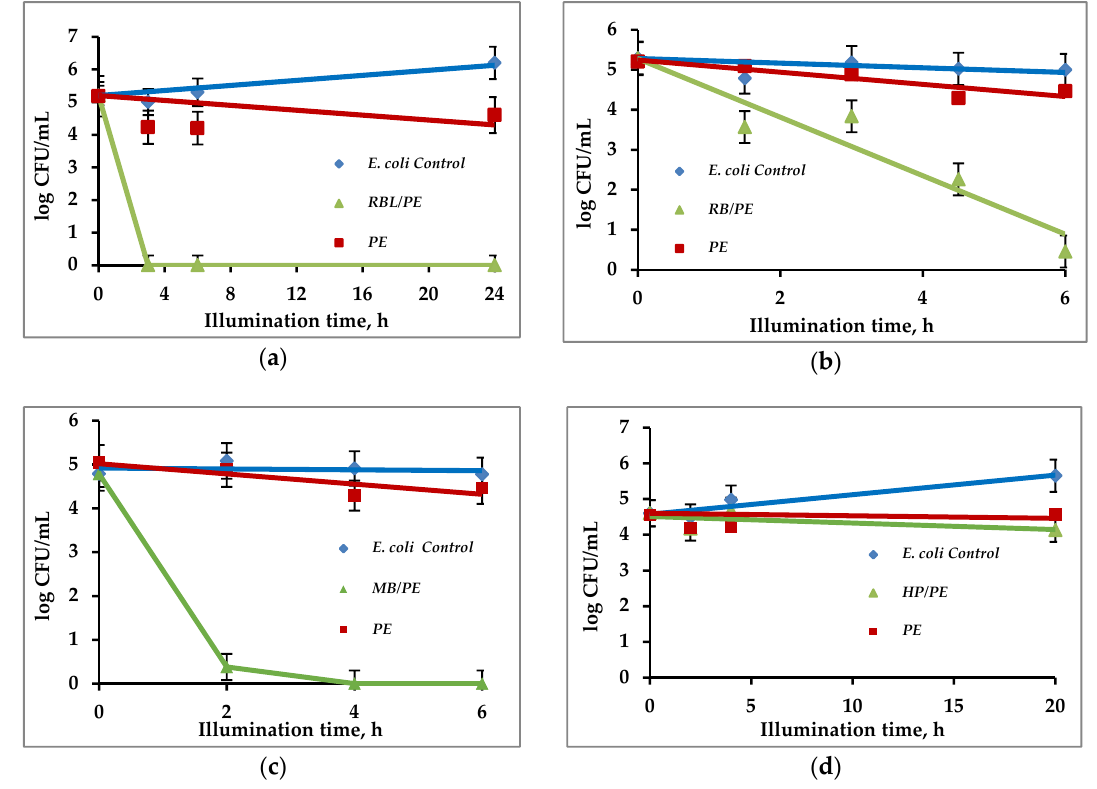
Figure 4. Effect of PSs immobilized onto polymers on the concentration of E. coli under illumination with 1.25 mW/cm 2 white light. ( a ) 1% RBL/PE at a 320 g/L loading; ( b ) 1% RB/PE at a 320 g/L loading; ( c ) 1% MB/PE at a 220 g/L loading; ( d ) 1% HP/PE at a 400 g/L loading. Control experiments— E. coli in the absence of any polymer and in the presence of PE.